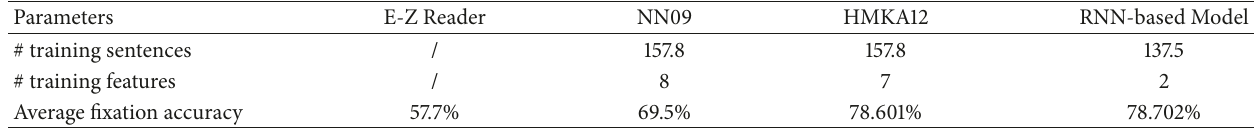
Table 4: Comparison between E-Z Reader, NN09, HMKA12, and RNN-based models.